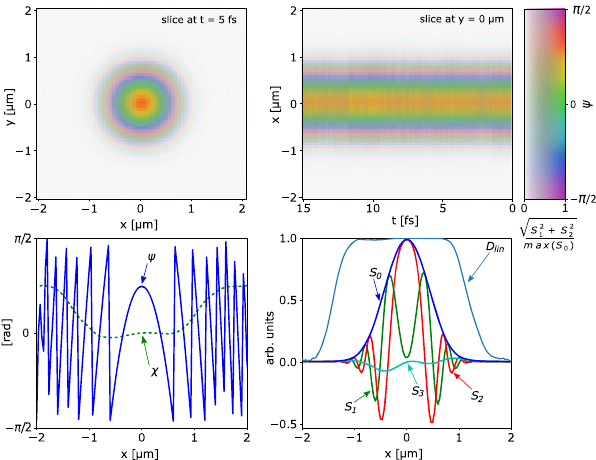
FIG. 10. Polarization properties of radiation for the setup geometry optimized for spatial polarization shaping with crossed helical undulators. Stokes parameters averaged over 15 fs. Notation is the same as in Fig. 9, except the Stokes vector and angles are calculated for the radiation at slice y ¼ 0 and averaged over time. Radiation power is 3 GW.